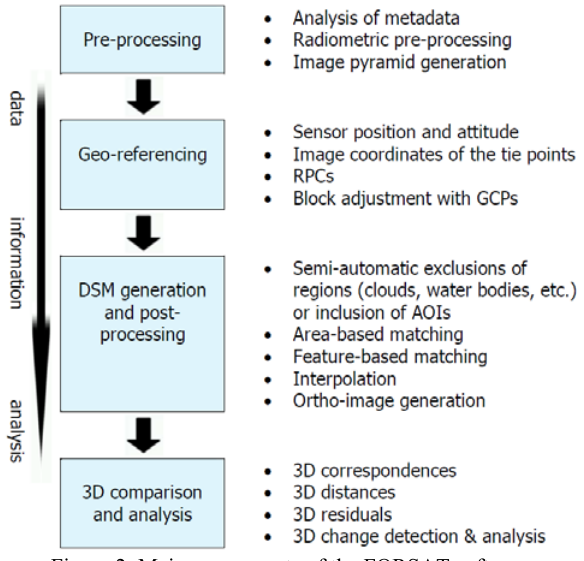
Figure 2. Main components of the FORSAT